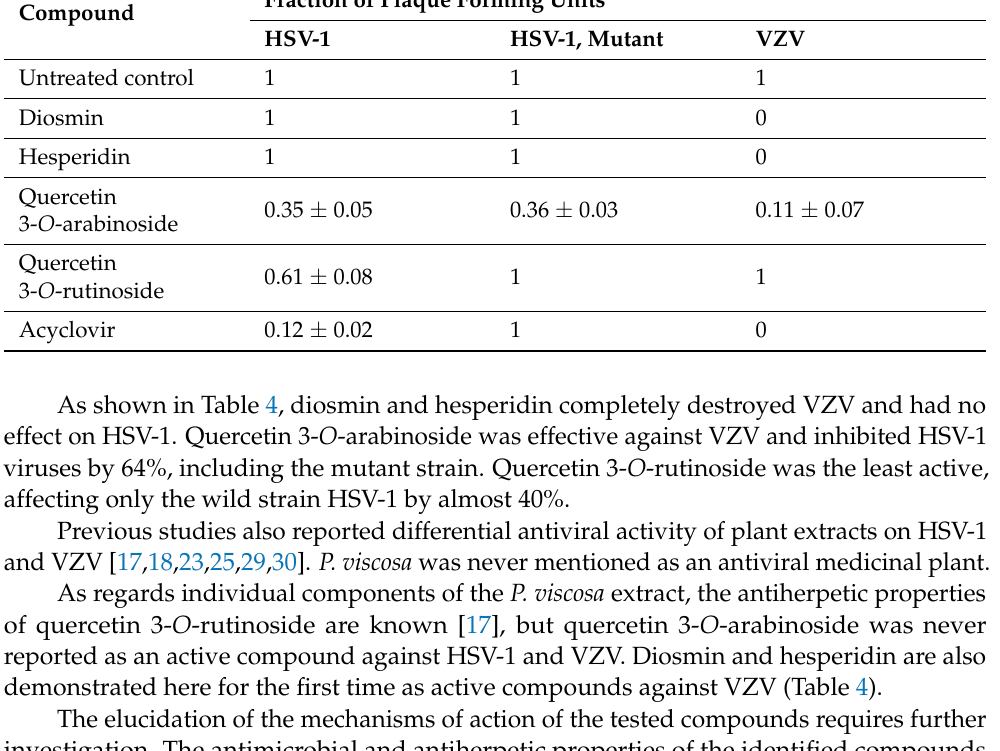
Table 4. Antiviral properties of phytochemicals of P. viscosa .